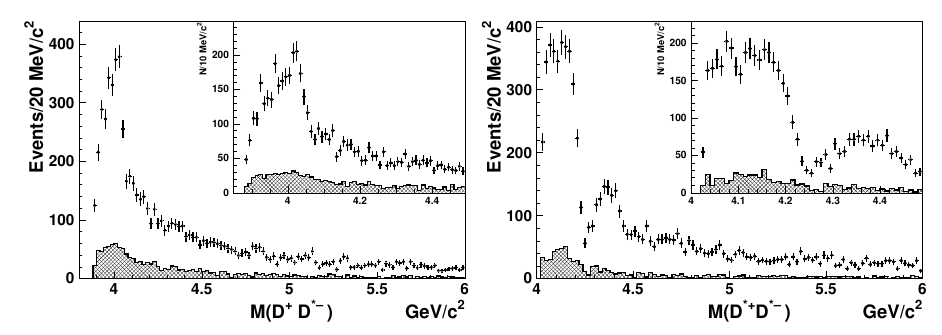
Figure 1. The a) D + D ∗− and b) D ∗ + D ∗− mass spectra in the data after applying all selection criteria (points with error bars). The sum of backgrounds (1)–(3) is shown as the hatched histogram. The inset shows the spectrum near the threshold with finer bins.